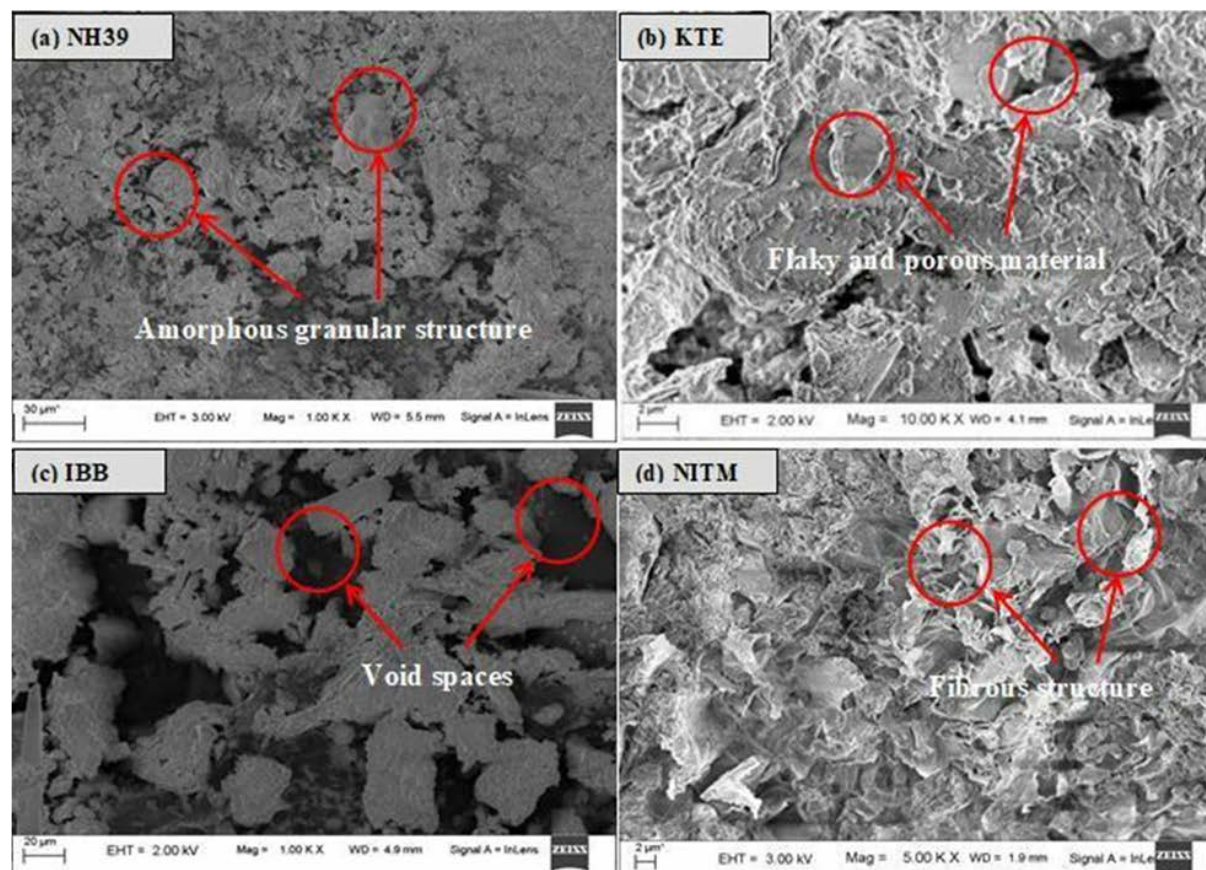
Figure 7. FESEM analysis of Northeast Indian